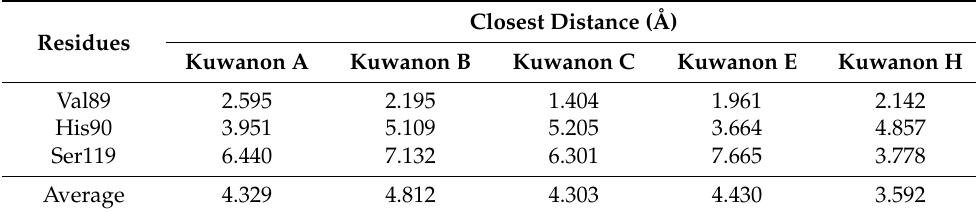
Table 4. The closest distance between the kuwanon derivatives and amino acids in the entrance/exit routes of COX active